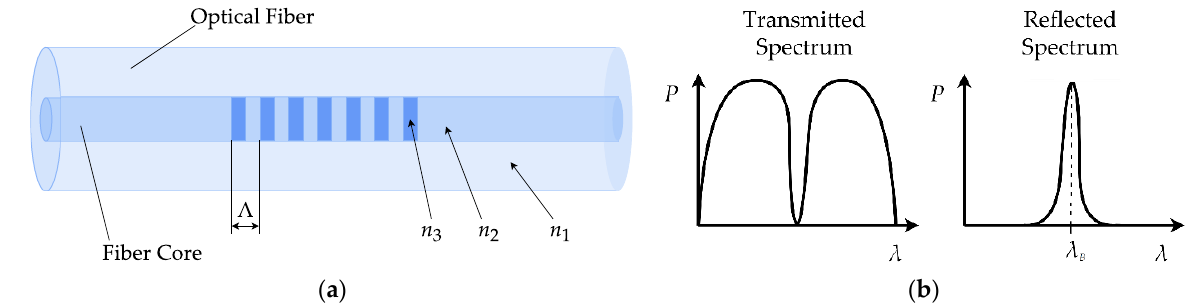
Figure 2. ( a ) Schematic representation of a fiber Bragg grating: Λ is the grating period, n 1 is the refractive index of the fiber cladding, n 2 is the refractive index of the fiber core, and n 3 is the refractive index of periodic variations forming the FBG; ( b ) spectra of transmitted and reflected light of an FBG.